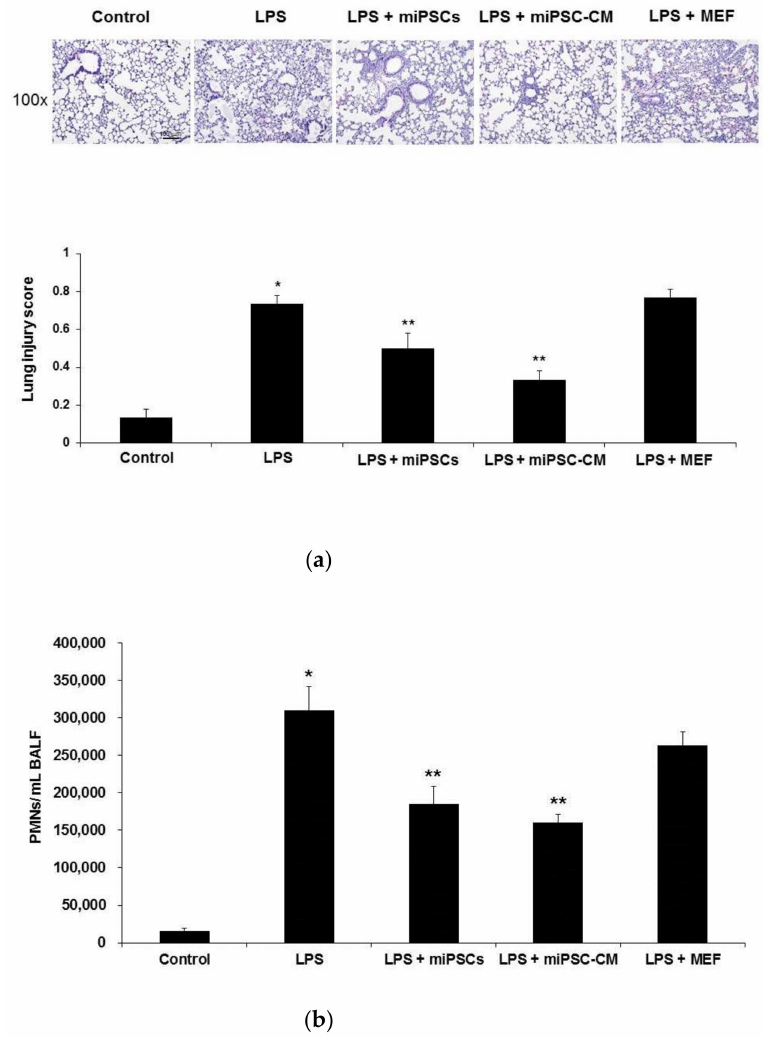
Figure 1. Administration of murine-induced pluripotent stem cells (miPSCs) or conditioned medium of miPSCs (miPSC-CM) improved the histological features of mice with lipopolysaccharide (LPS)- induced acute lung injury (ALI) and prevented the accumulation of neutrophils after LPS-induced ALI. ( a ) Hematoxylin and eosin staining of lung sections (original magnification × 100) demonstrated the attenuation of lung injury in mice receiving miPSCs (LPS + miPSCs) or miPSC-CM (LPS + miPSC- CM) 24 h after LPS-induced ALI (LPS). Control mice injected with intratracheal phosphate-buffered saline (PBS) showed minimal histopathological abnormalities. ALI mice that received miPSCs or miPSC-CM had significantly lower histopathological lung injury scores compared to ALI mice. The lung injury score represents the average result from two independent readers. Data are the mean ± standard deviation (SD). Mice that received mouse embryonic fibroblasts (MEFs; LPS + MEFs) showed no improvement in the severity of LPS-induced ALI compared to untreated mice (LPS) at 24 h. ( b ) Bronchoalveolar lavage fluid (BALF) showed a marked accumulation of polymorphonuclear neutrophils (PMNs) in the lungs of LPS-induced ALI mice (LPS). Mice treated with miPSCs or miPSC-CM had significantly lower numbers of BALF PMNs. Data are the mean ± SD. * p < 0.05, compared to control mice; ** p < 0.05, compared to LPS-induced ALI mice; n = 6 per